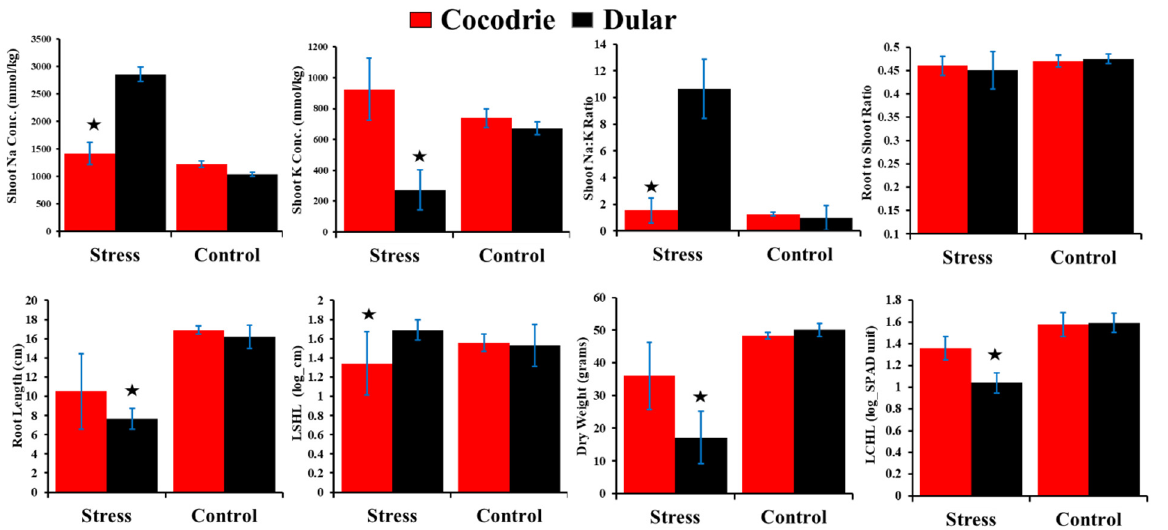
Figure 3. Comparison of Cocodrie and Dular under stress and control environment for alkalinity tolerance traits. Asterisks indicate significant difference between the means of Cocodrie and Dular under control and alkaline stress environment at 0.05 level of probability.